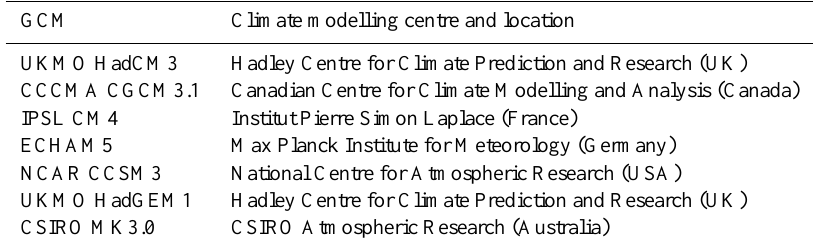
Table 2. GCMs that were pattern-scaled by ClimGen and applied in this study. GCM Climate modelling centre and